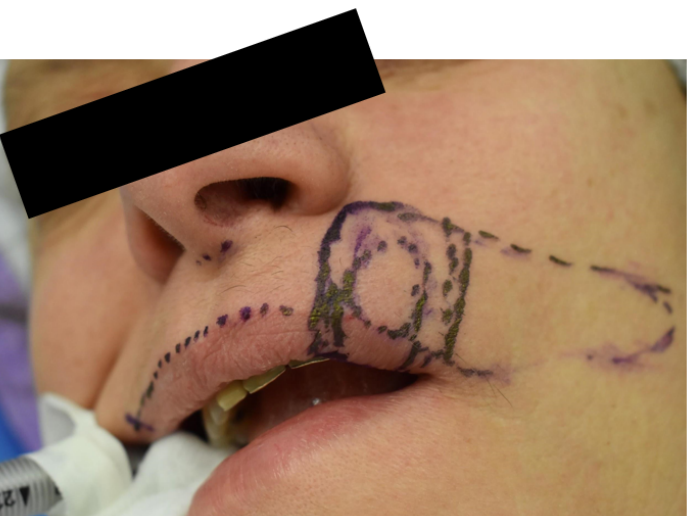
Figure 11. Case 6: Polymorphous low-grade adenocarcinoma of the left upper lip and reconstructive planning.